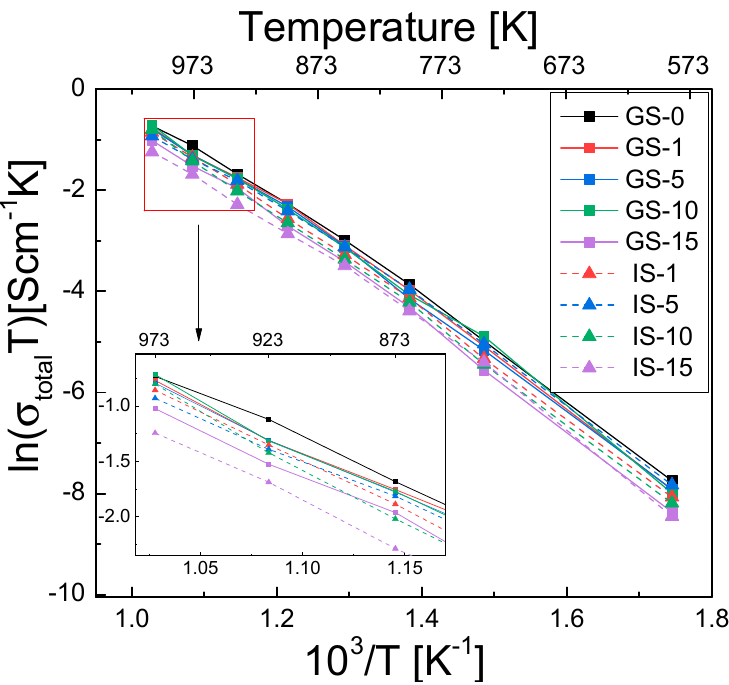
Figure 7. Temperature dependence of total electrical conductivity in the form of Arrhenius plots for all investigated sinter samples. Inset: Arrhenius plot in the temperature range of 873–973 K.